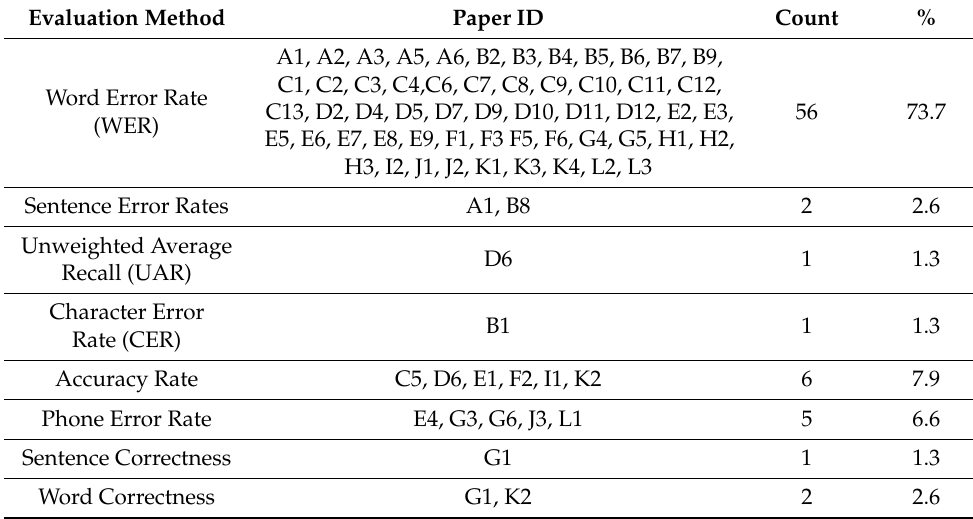
Table 6. Evaluation methods